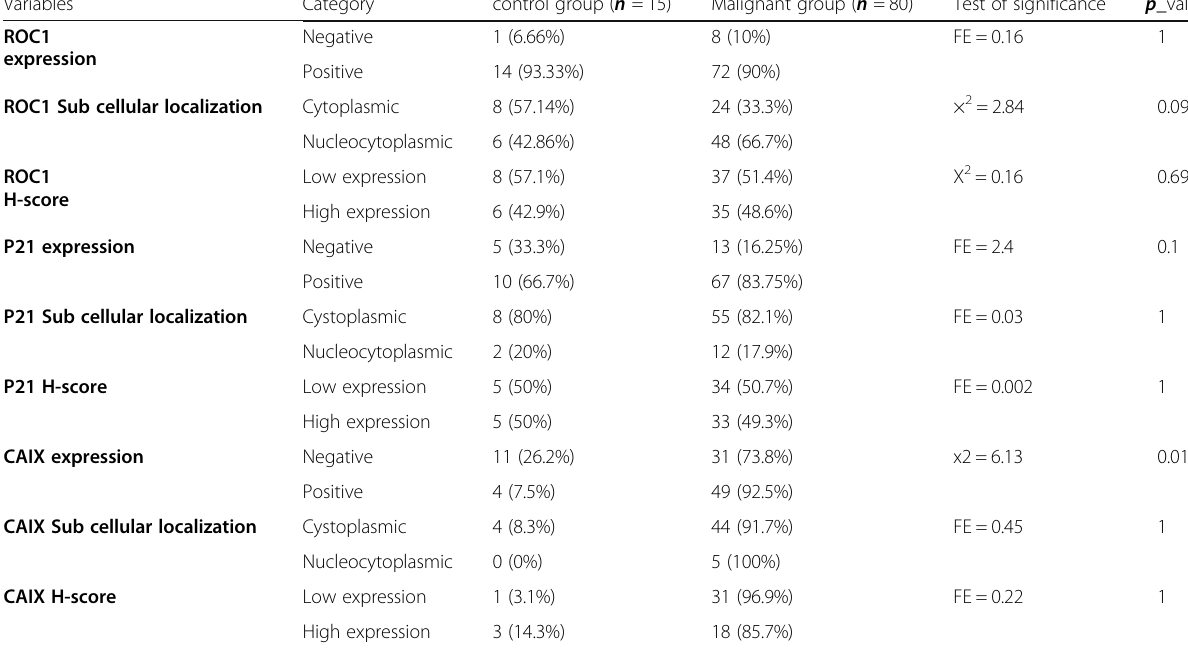
Table 3 Comparison between ROC1, P21 and CAIX expression in control group and bladder carcinoma cases Variables